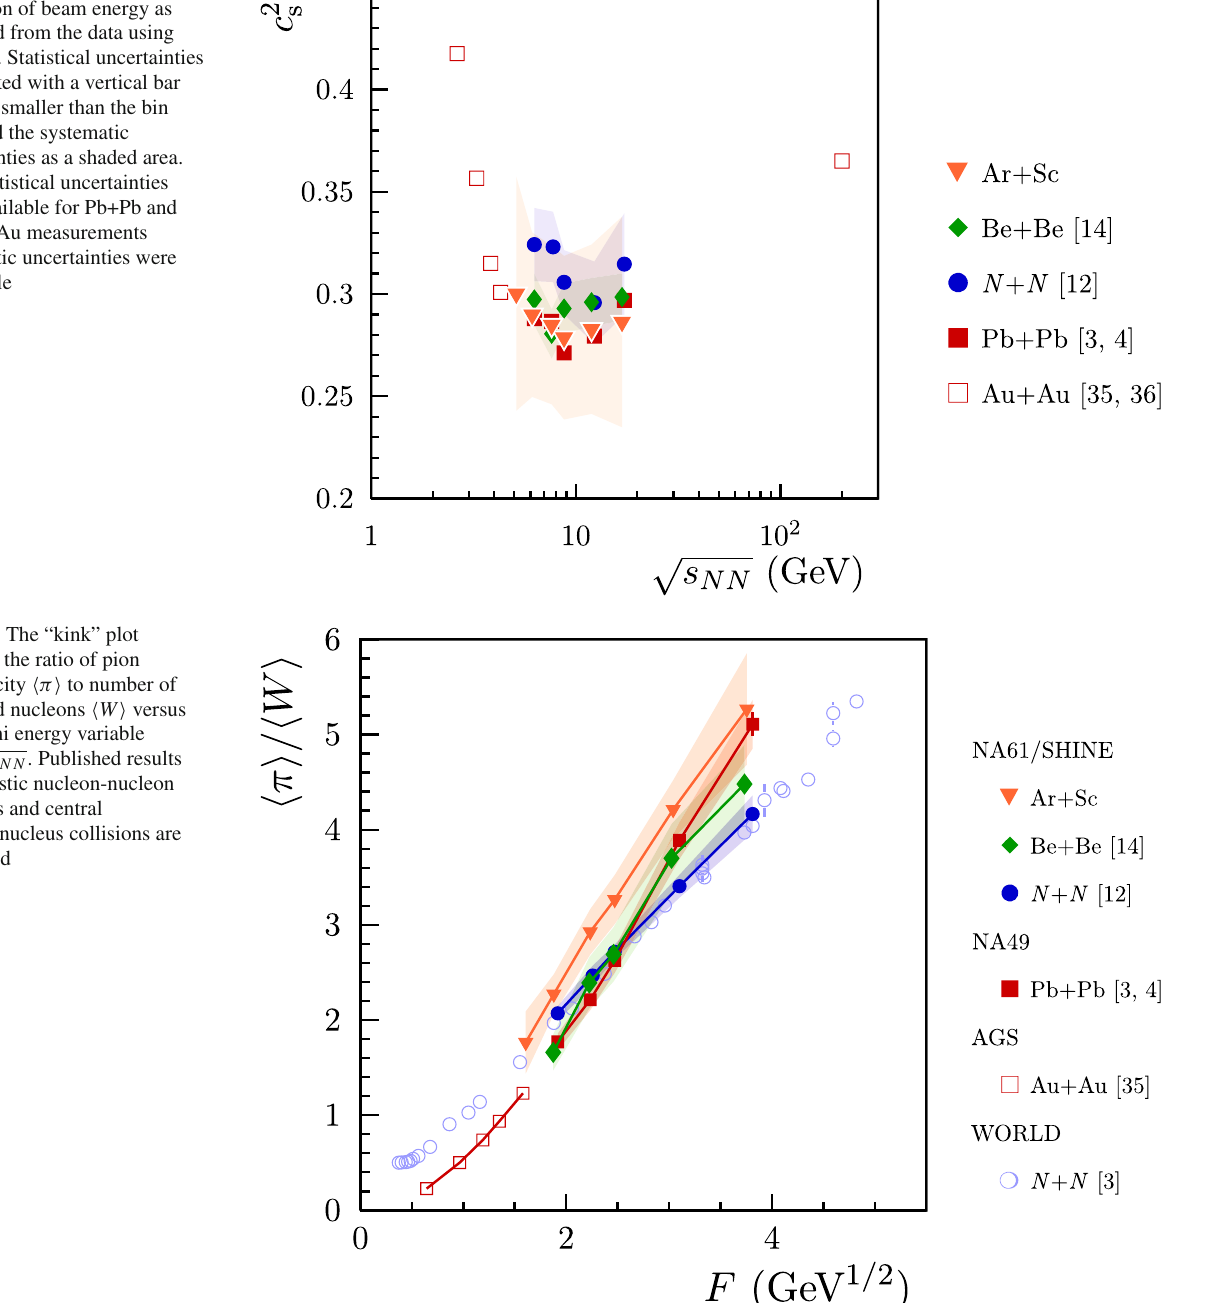
showing the ratio of pion multiplicity (cid:5) π (cid:6) to number of wounded nucleons (cid:5) W (cid:6) versus the Fermi energy variable √ F ≈ 4 s NN . Published results for inelastic nucleon-nucleon reactions and central nucleus-nucleus collisions are